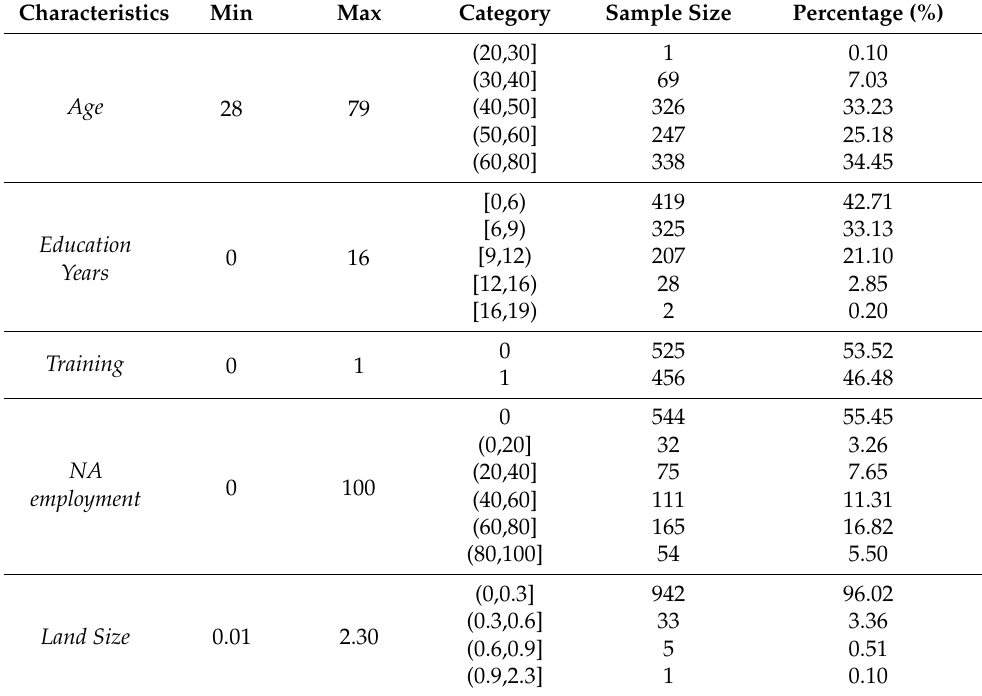
Table 3. Summarized statistics for respondents’ demographic